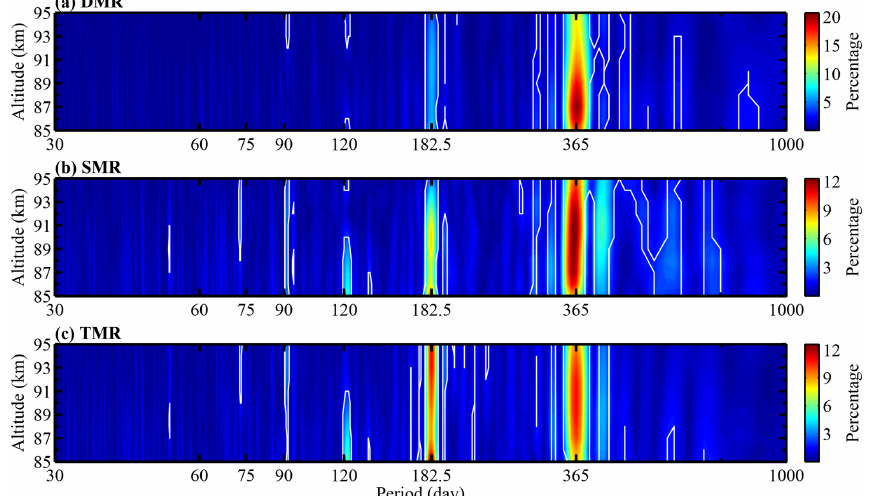
Figure 4. Contours of the Lomb–Scargle spectral (see, e.g., Lomb, 1976; Scargle, 1982) relative amplitudes of the (a) DMR, (b) SMR and (c) TMR densities. The white lines represent the 99% significance